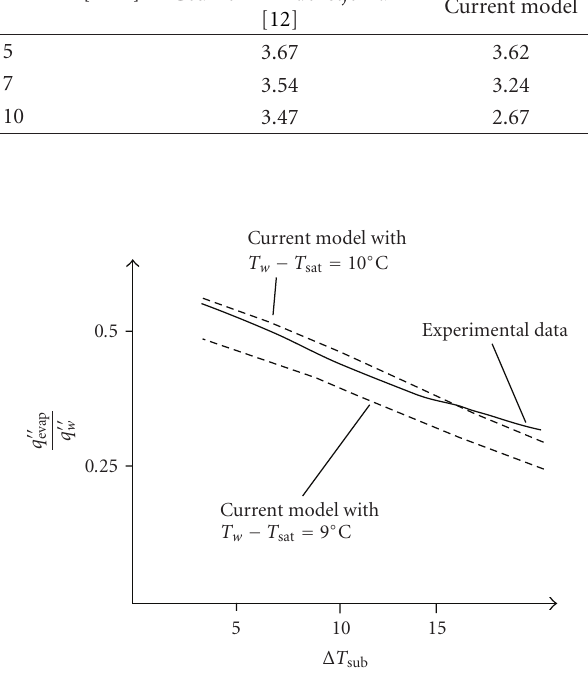
Figure 4: A comparison between the predicted and experimental evaporation heat flux